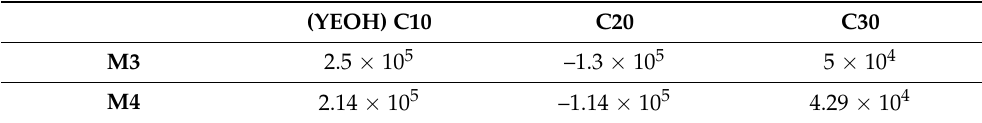
Table 3. Parameters for hyper-elastic materials.